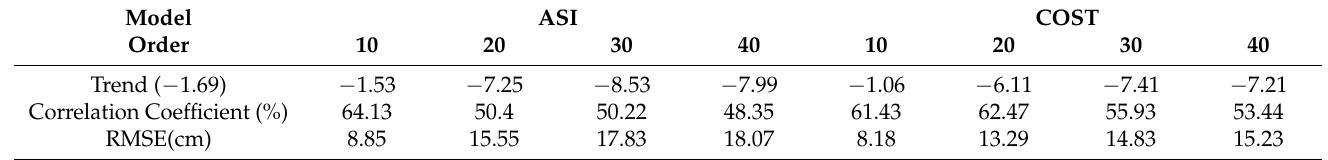
Figure 3. The Swarm-TWSC time series and the long-time trend with different order and GRACE- TWSC’s in Basin 1. The left one is Swarm from ASI and the right one is Swarm from COST. Table 3. The results of Swarm-TWSC of different order compared with GRACE-TWSC in Basin 1.